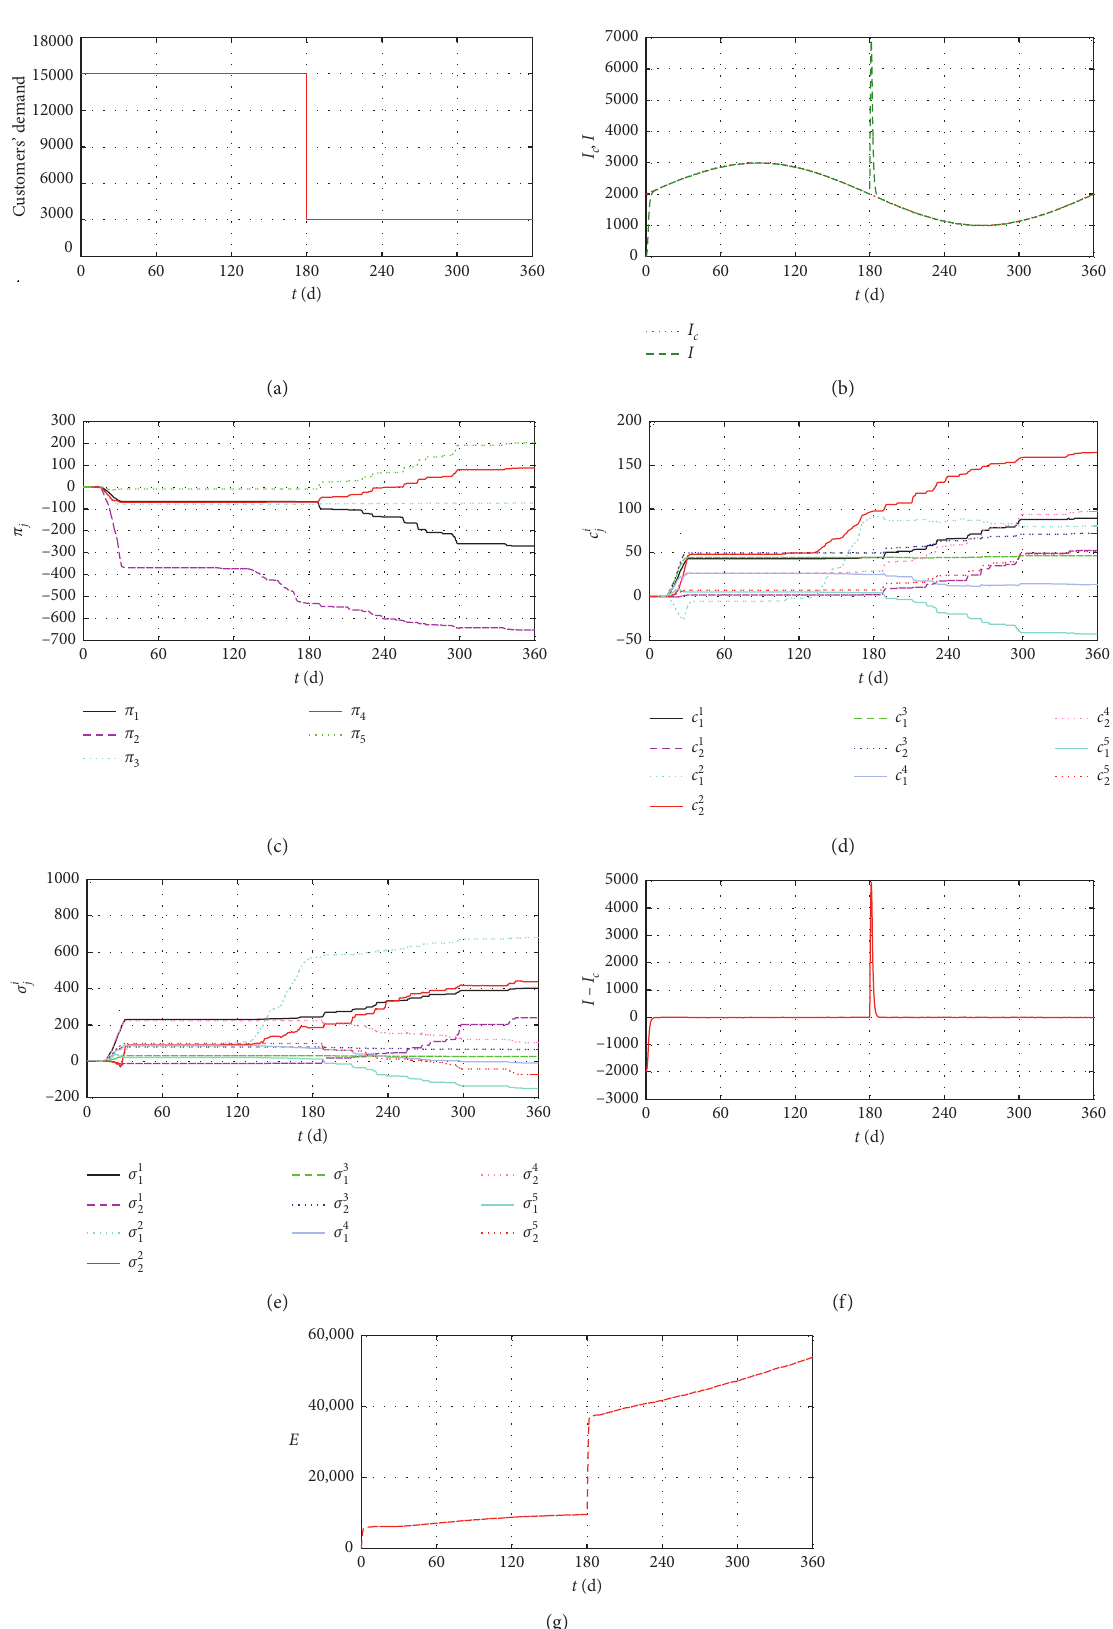
Figure 3: Simulation results under step demand. (a) Customers’ demand. (b) Inventory curves. (c) Curves of adaptive parameter π (d) Curves of adaptive parameter c i j . (e) Curves of adaptive parameter σ i j . (f) Error curve of I − I c . (g) Curve of E